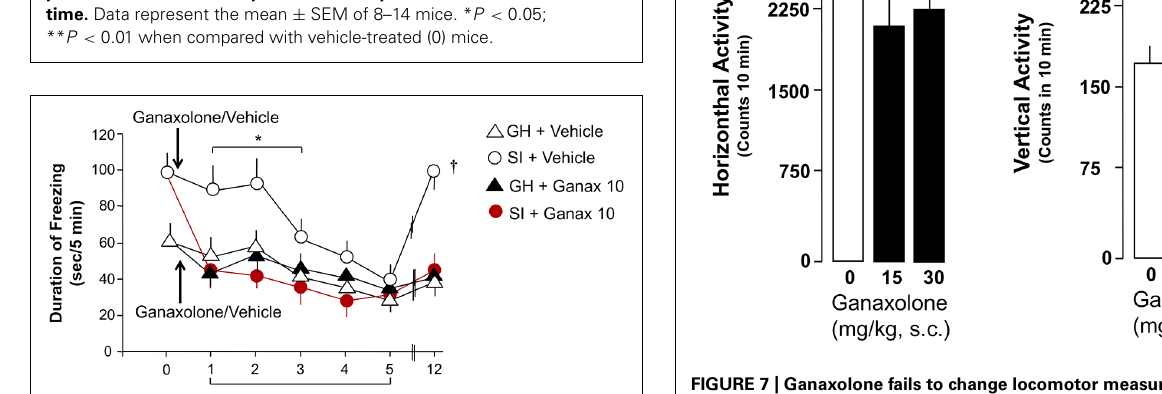
FIGURE 7 | Ganaxolone fails to change locomotor measures assessed as horizontal and vertical activity in group-housed mice. Data represent the mean ± SEM of six group-housed